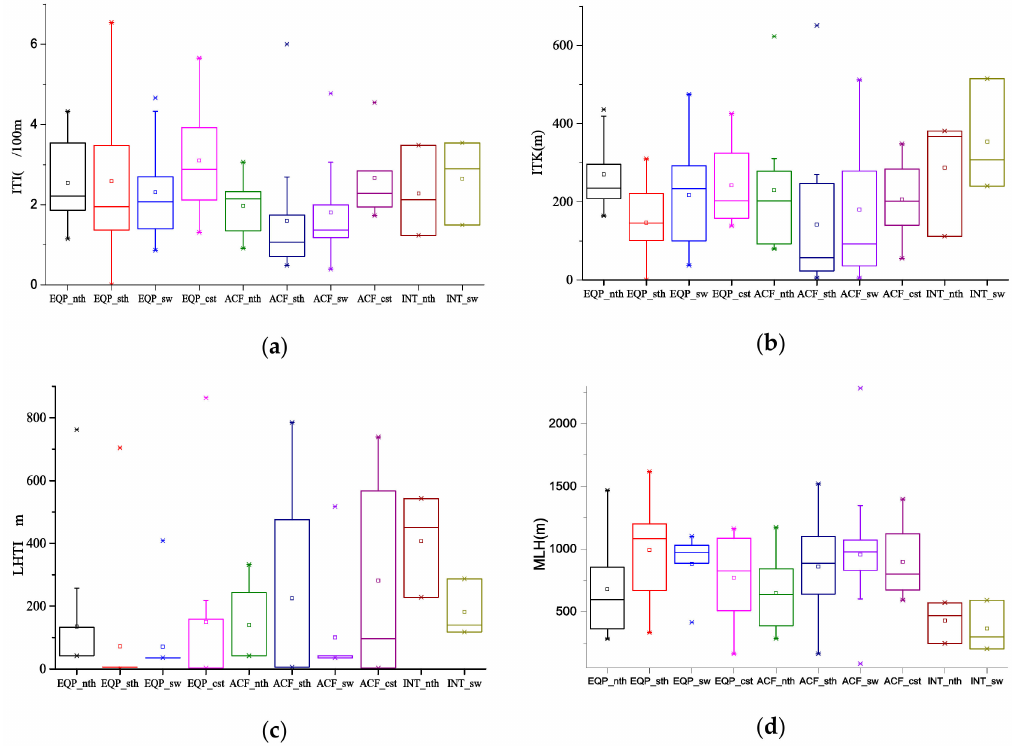
Figure 8. Inversion intensity(ITI) ( a ), height di ff erence in the temperature inversion(ITK) ( b ), the lower height of temperature inversion (LHTI) ( c ) and mixed-layer height (MLH) ( d ) on RPHPDs (regional PM 2.5 pollutiondays)underthetentypes. Rectangle: 25%–75%(quartile); rectanglemidline: themedian; end of the line: 5%–95%; × : 1% and 99%; (cid:3) :